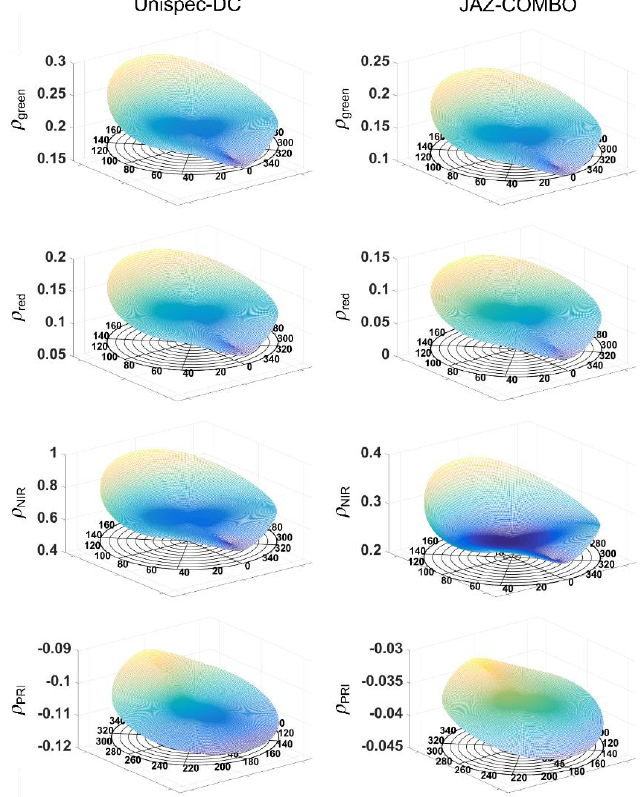
Figure 7. BRDF models for UDC and JC.